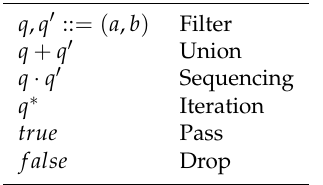
Table 2. Felix query syntax